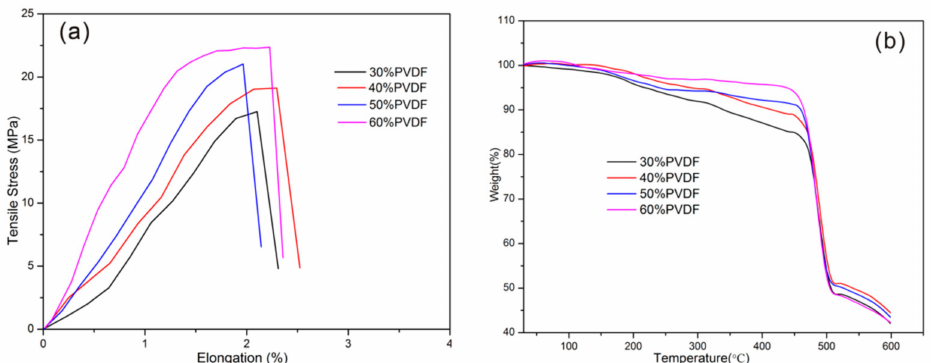
Figure 7. The stress-strain relationship ( a ) and the thermogravimetric (TG) curves ( b ) of the s -PI-PVDF composite